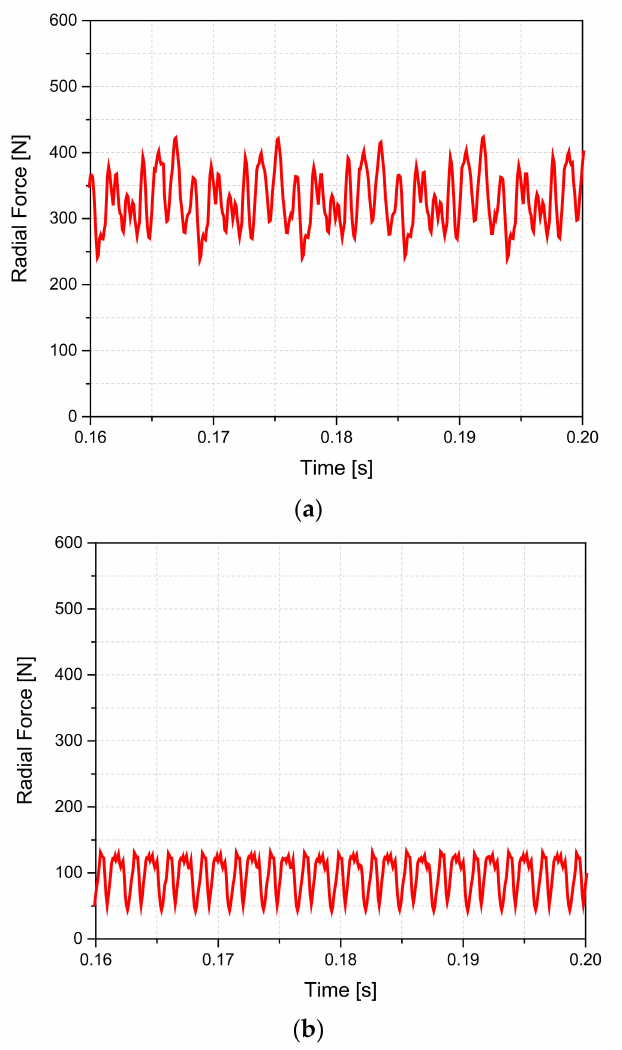
Figure 12. Radial force plot for the employed machine model using the ( a ) customary, and ( b ) pro- posed BL-WRSM topologies based on sub-harmonic field-excitation